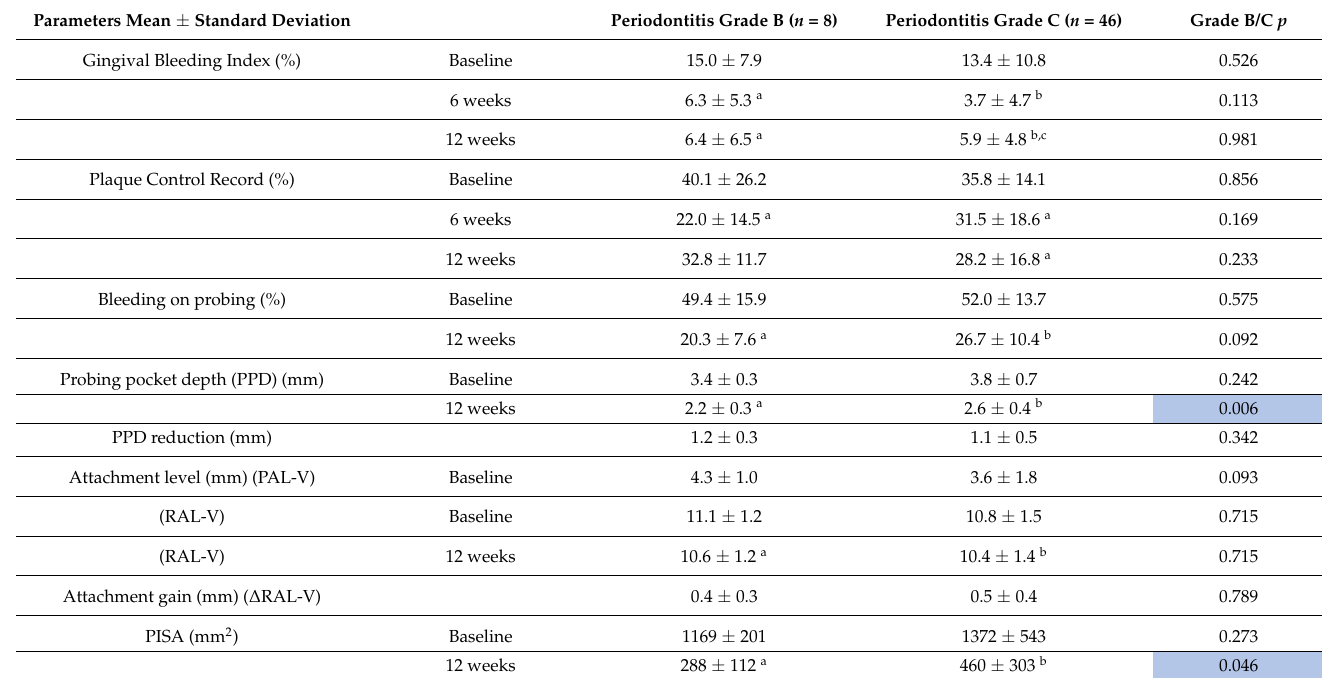
Table 2. Individuals’ periodontal variables and change of periodontal variables after therapy (PAL-V: clinical vertical attachment level; RAL-V: relative vertical attachment